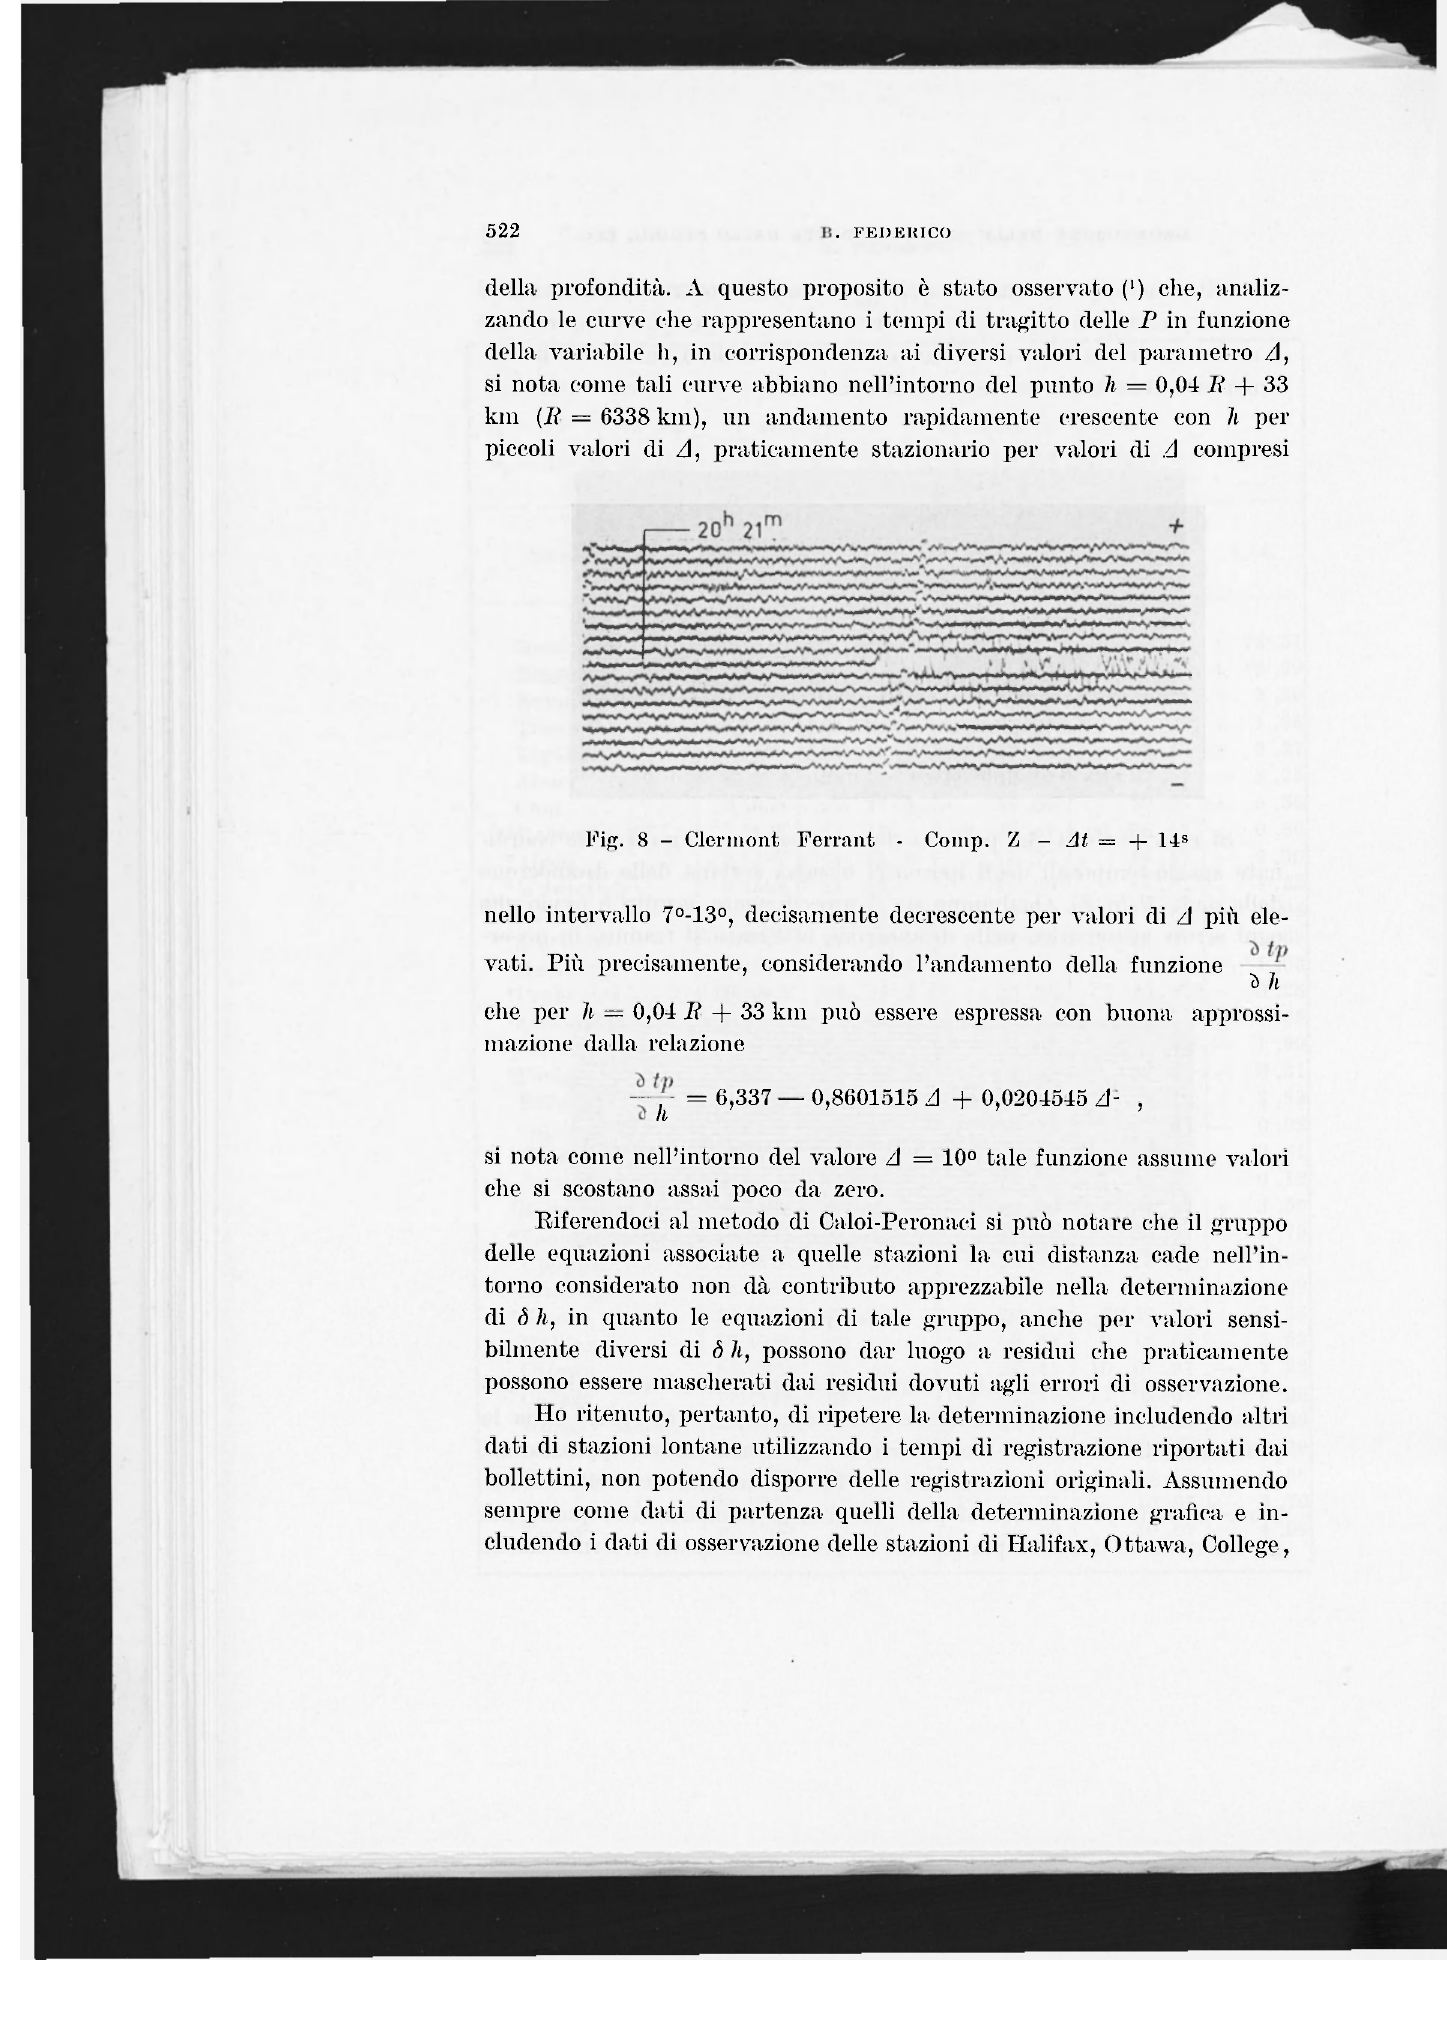
Fig. 8 - Clermont Ferrant - Comp. Z - At = + 14 s